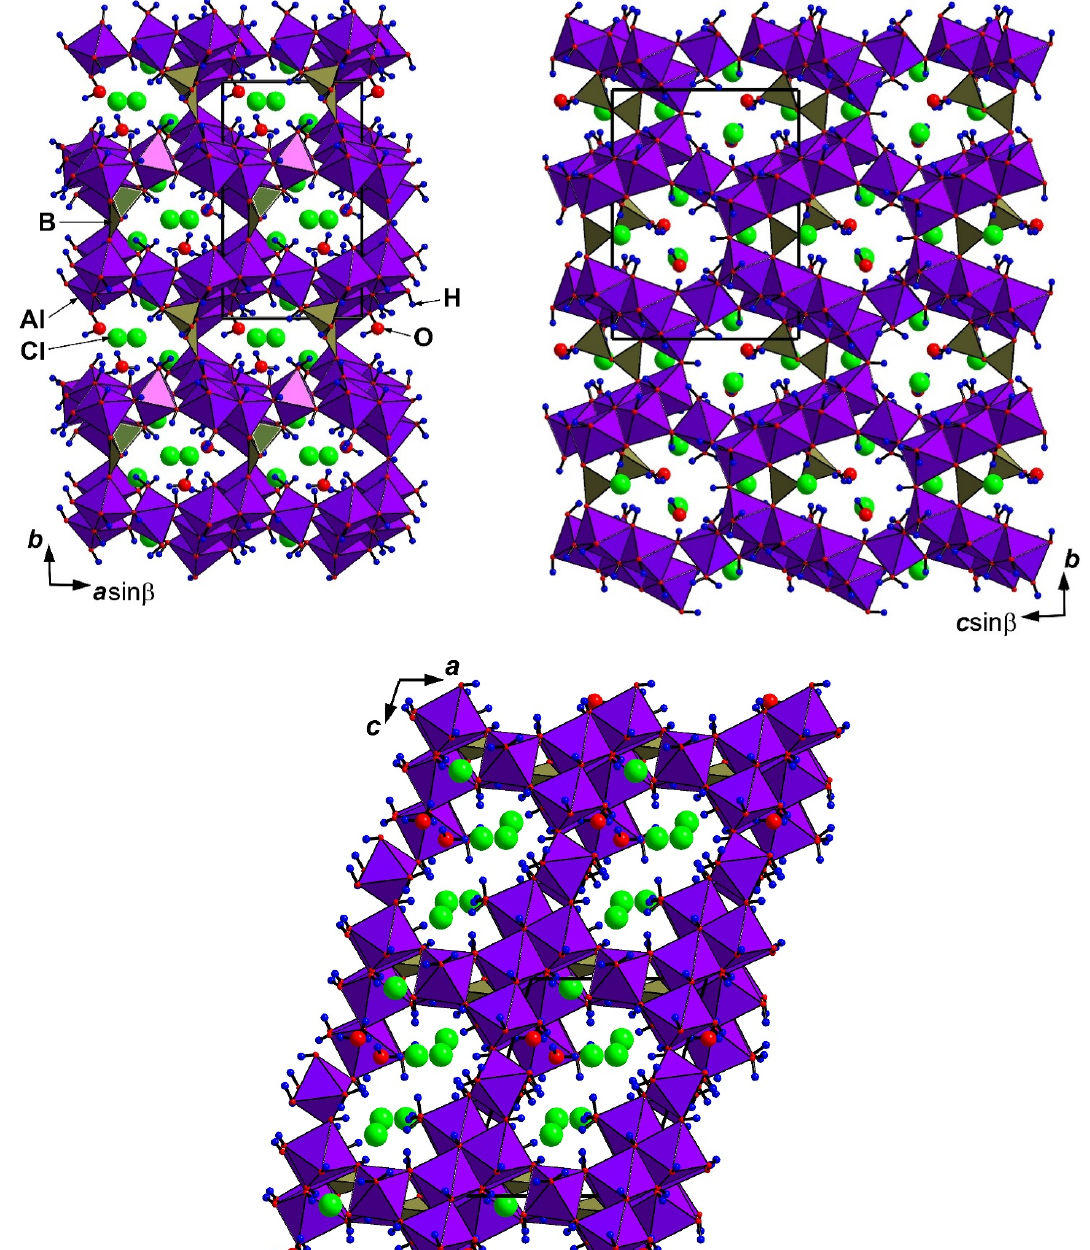
Figure 2. The crystal structure of krasnoshteinite in three projections. The unit cell is outlined.